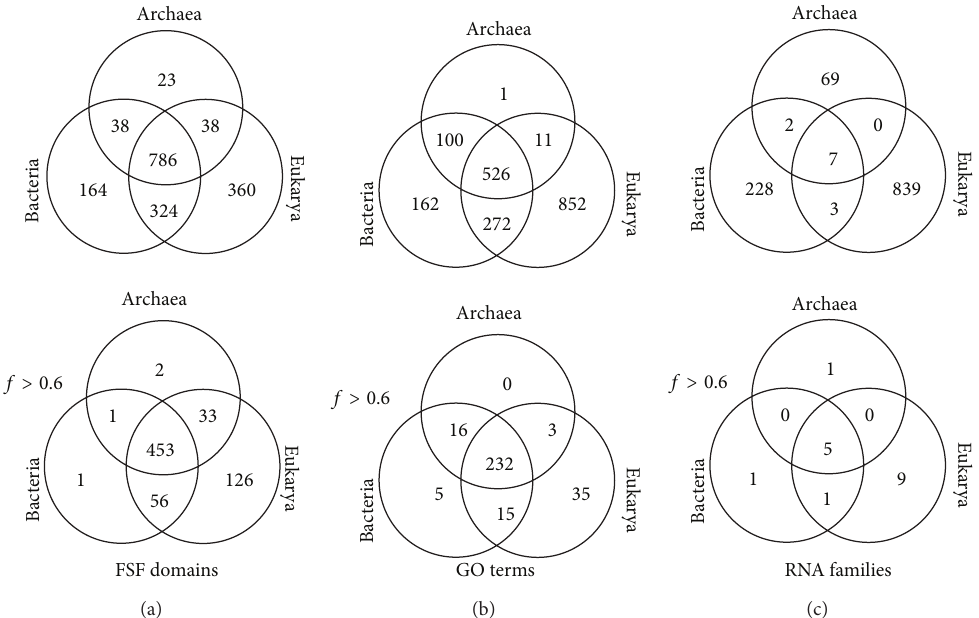
Figure 6: Venn diagrams displaying the distributions of 1,733 FSF domains (a), 1,924 terminal GO terms (b), and 1,148 RNA families (c) in the genomes of the three domains of life. FSF domain data was taken from Nasir et al. [122, 123] and included 981 completely sequenced proteomes from 70 Archaea, 652 Bacteria, and 259 Eukarya. Terminal GO terms corresponding to the “molecular function” hierarchy defined by the GO database [118] were identified in 249 free-living organisms, including 45 Archaea, 183 Bacteria, and 21 Eukarya (data taken from [123]). The Venn diagram of RNA families and the distribution of Rfam clans and families in organisms were taken from Hoeppner et al. [129] and their Dataset S1. Shown below are distribution patterns for FSFs, GO terms, and RNA families that are present in more than 60% of the organisms examined ( 𝑓 > 0.6 ). All distributions highlight maximum sharing in the ancient ABE and BE taxonomic groups and minimal sharing in archaeal taxonomic